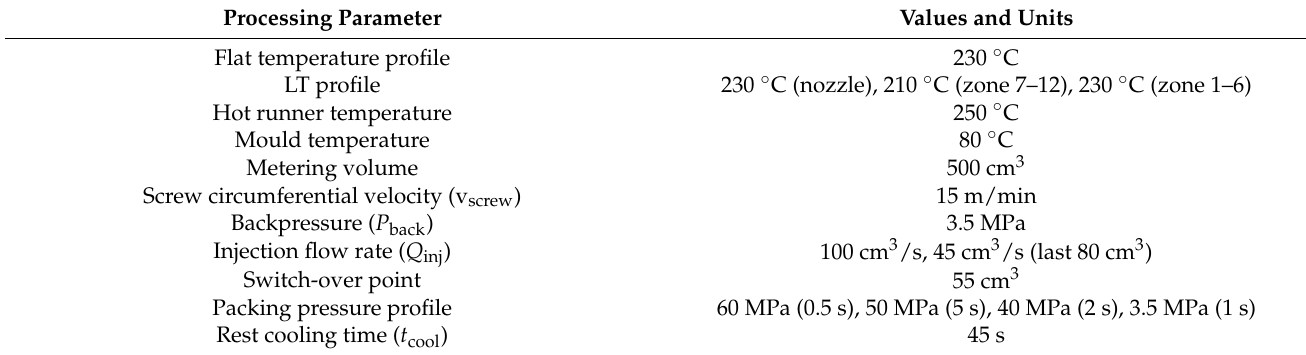
Table 1. Processing parameters for injection moulding and